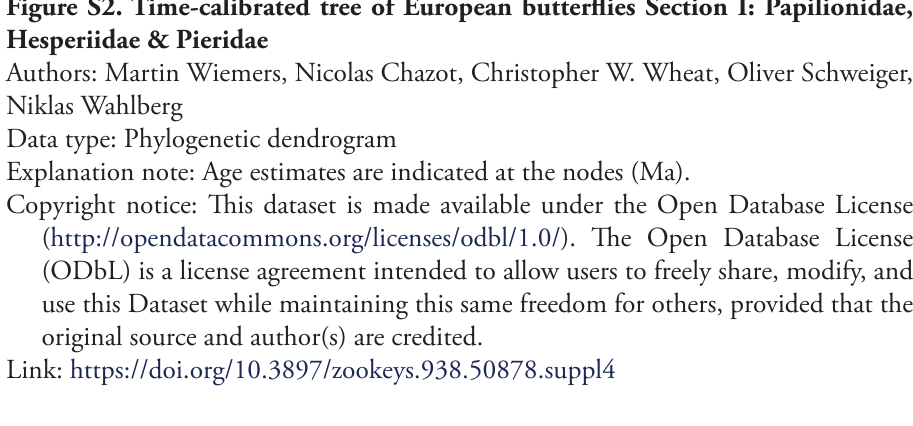
Figure S2. Time-calibrated tree of European butterflies Section I: Papilionidae, Hesperiidae &